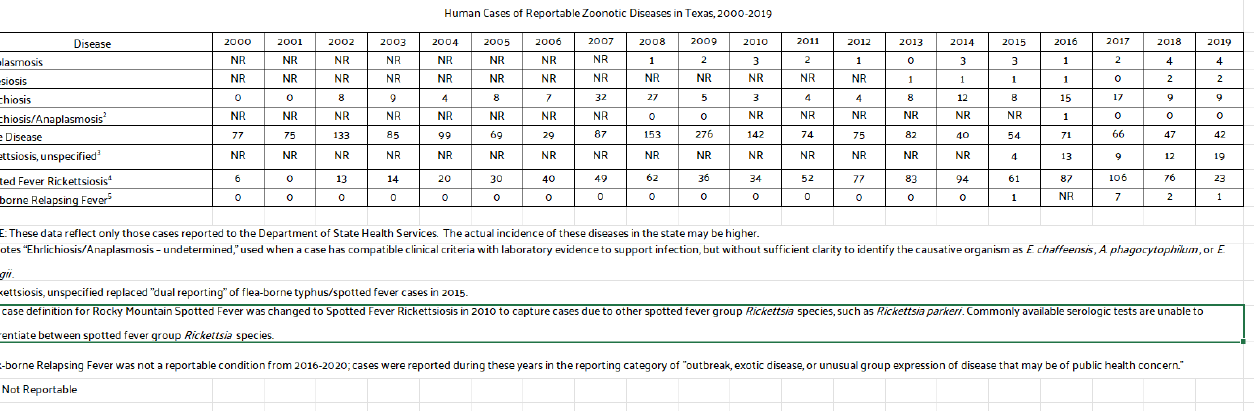
Figure 11. Selected human cases of TBDs in Texas from 2000 to 2019